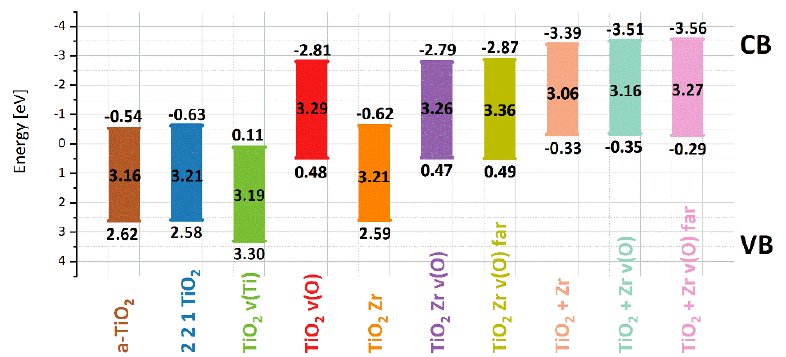
Figure 3. Valence band maximum and conductionband minimum for structures based on a-TiO 2 crystals structure modified by dopants and vacancies calculated by DFT/PBE+U method.